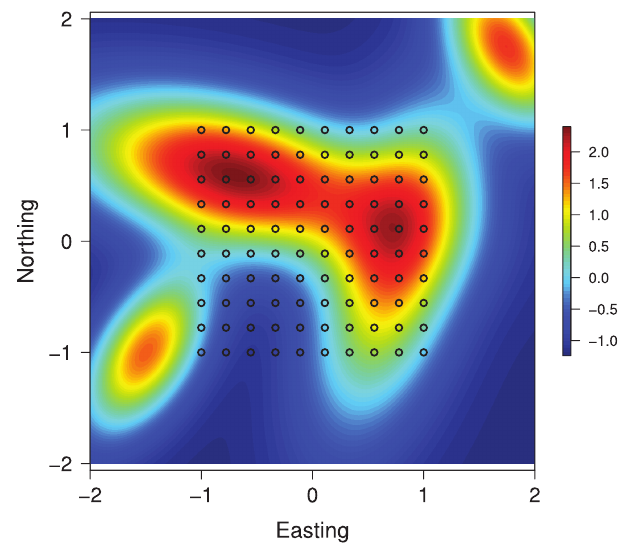
Figure 1. Map of spatial variation in habitat quality for a simulated population of individuals exposed to an array of 100 traps. Trap locations are superimposed on map.